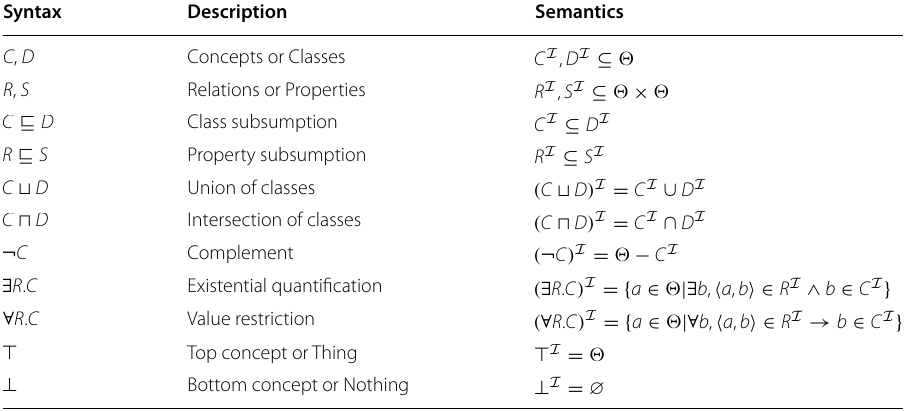
Table 17 Syntax and semantics of description logic